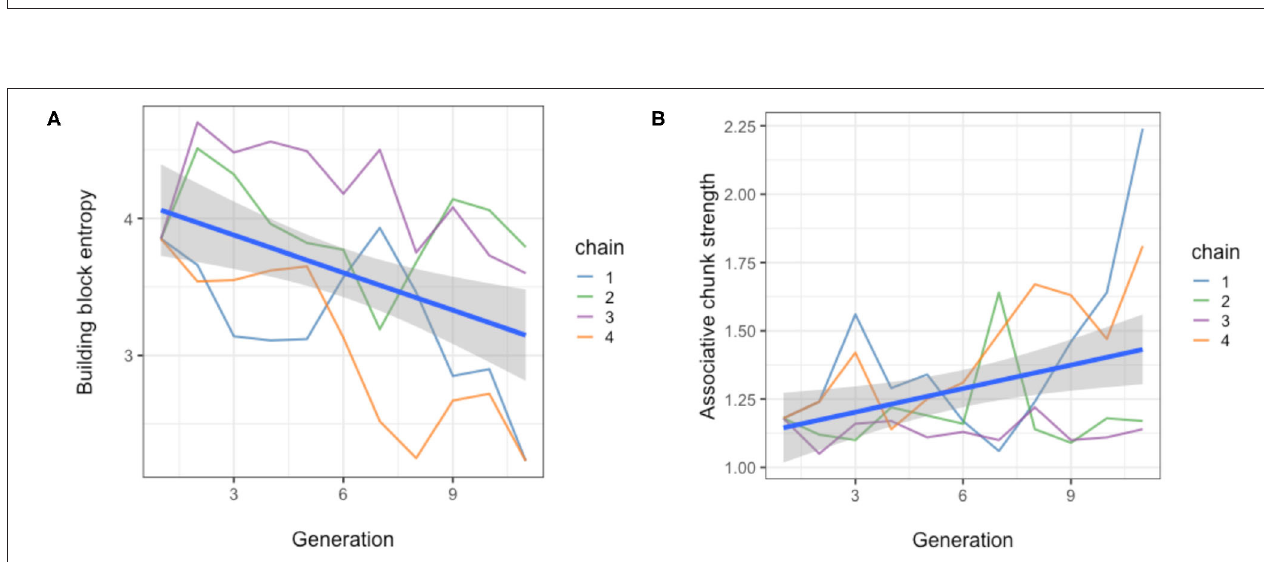
FIGURE 10 | Two measures demonstrating the emergence of motivic patterns and repetition. (A) Entropy of the whistle sets over generations for all four chains, demonstrating that structure and reuse of elements increases. (B) Associative chunk strength of the whistle sets over generations for all four chains, showing an increase in reoccurrences of bigram and trigram sequences of basic whistle elements, and thereby demonstrating the emergence of sequential structure. The blue lines show linear model fits and the grey areas are the 95% confidence intervals.